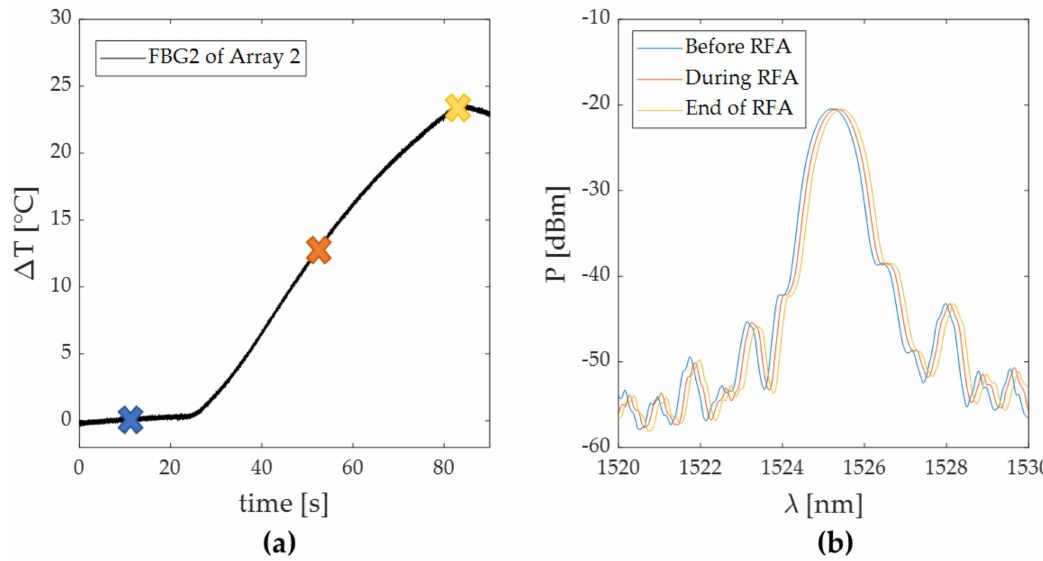
Figure 6. Focus on the temperature variation recorded during Trial 1 by FBG 2 of Array 2: ( a ) temperature trend zoomed in on the pre-treatment and RFA phases; ( b ) optical spectra relative to the FBG 2 recorded during the three di ff erent steps of the procedure marked as ( a ): before (blue line), during (red line) and at the end of the RF treatment (yellow